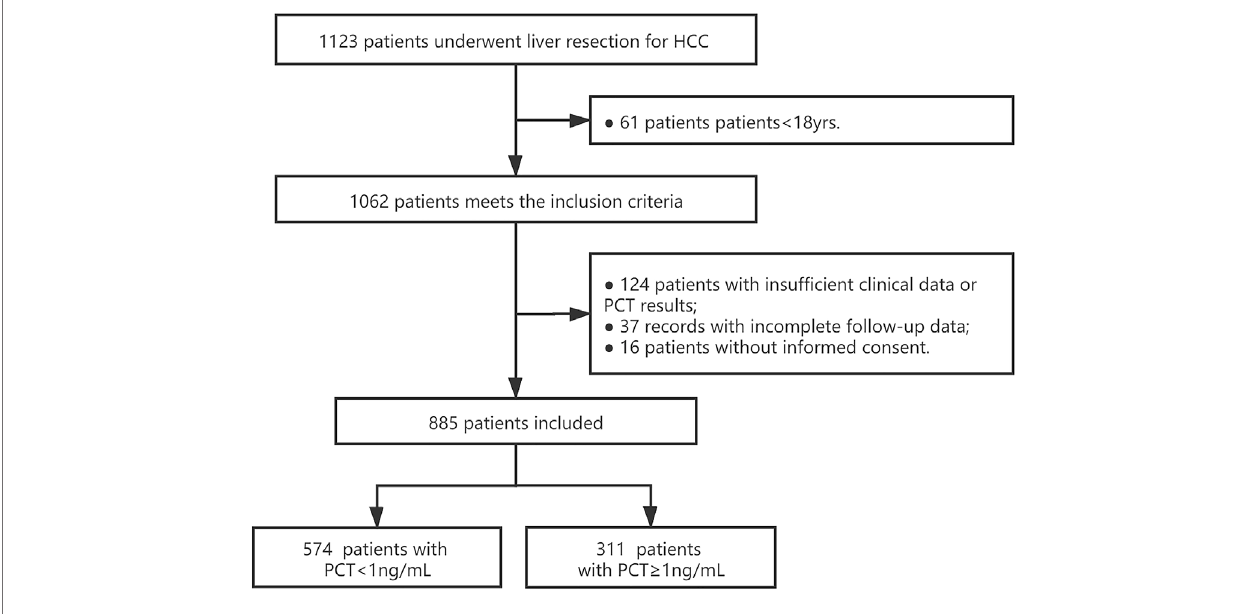
FIGURE 1 | Study fl ow. PCT: procalcitonin; HCC: hepatoma carcinoma cell.